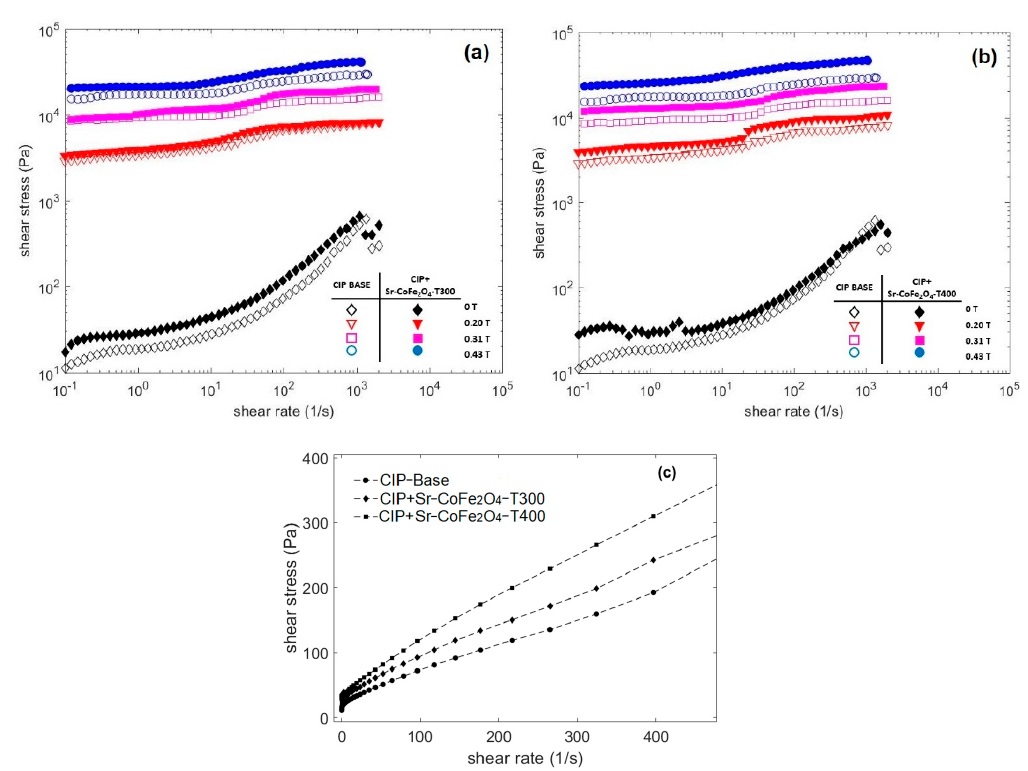
Figure 5. Shear stress of MRF as a function of shear rate at different magnetic fields ( a ) Comparison between MRF CIP-base and MRF CIP+Sr-CoFe 2 O 4 -T300 ( b ) Comparison between MRF CIP-base and MRF CIP+Sr-CoFe 2 O 4 -T400 ( c ) Comparison between MRF CIP-base, MRF CIP+Sr-CoFe 2 O 4 -T300 and MRF CIP+Sr-CoFe 2 O 4 -T400 at 0T in linear scale.